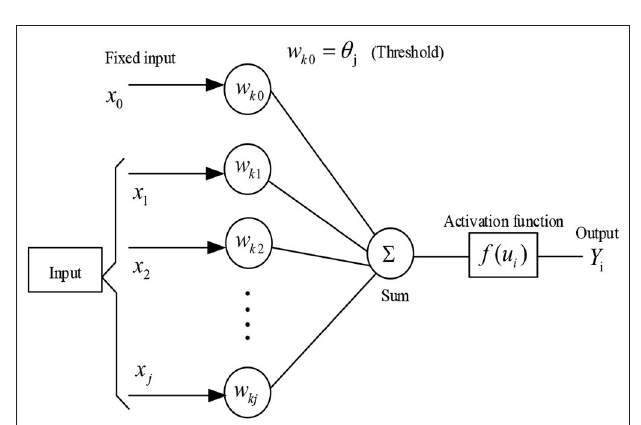
FIGURE 5 | Basic structure of a single-layer neural